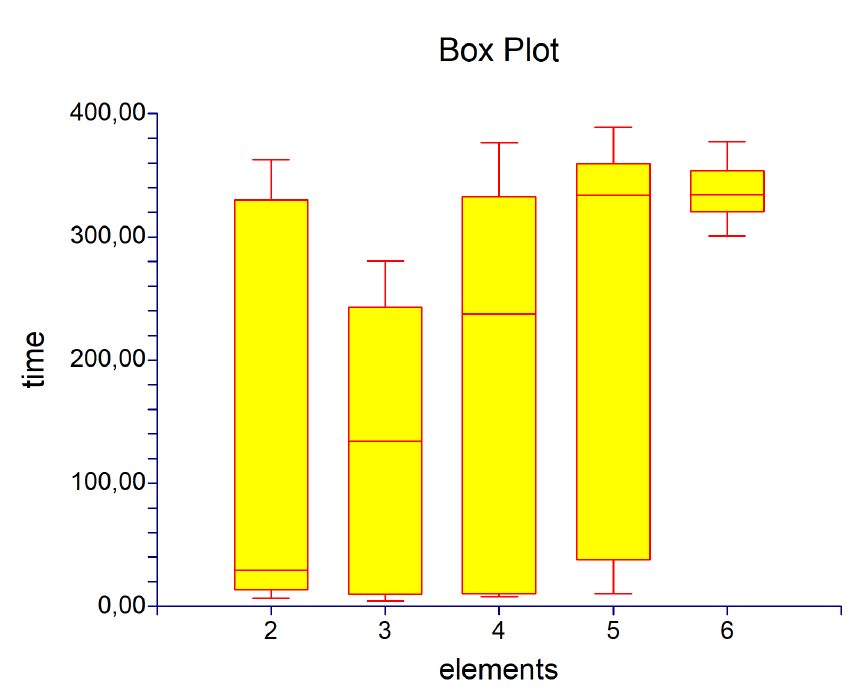
Figure 15. Exp. 4—Computing time means.